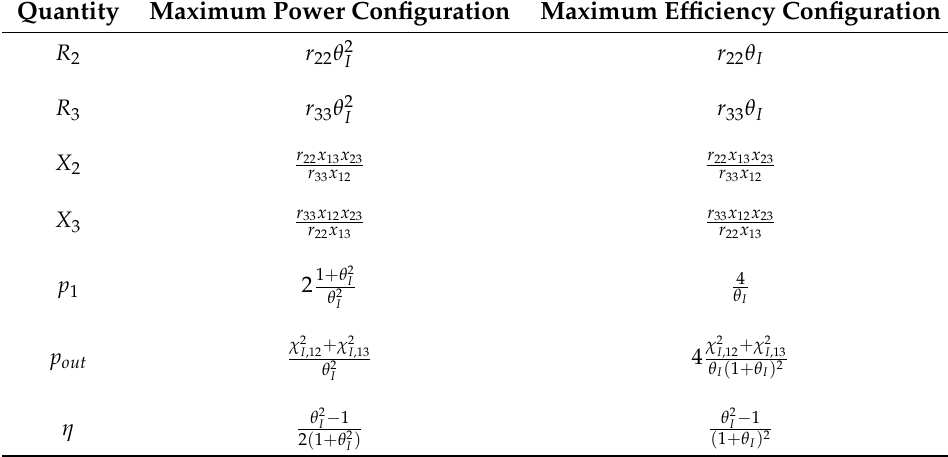
Table 6. Overview of the different quantities for the maximum power and the maximum efficiency solution for an inductive wireless power transfer (IWPT) system with one transmitter and two